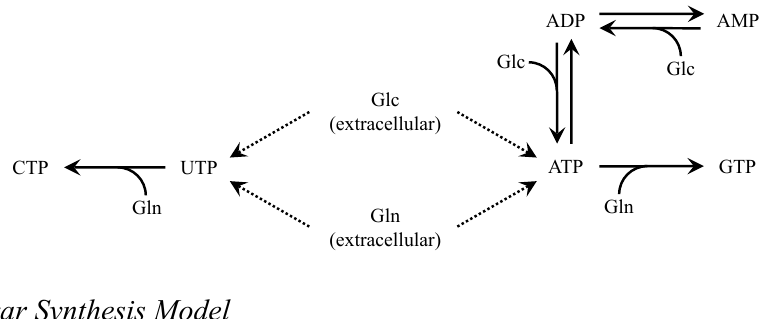
Figure 2. Reduced nucleotide synthesis network.